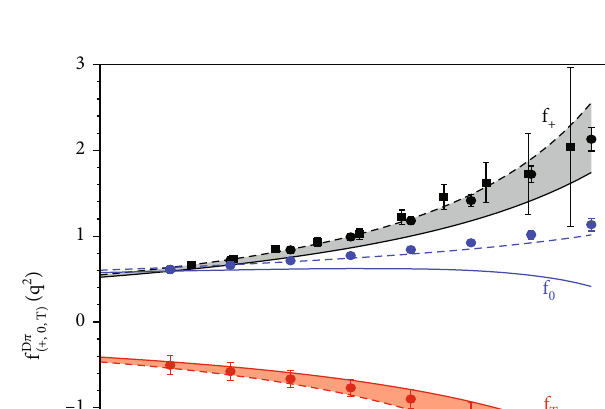
0 Þ = 0 : 737 ð 4 Þ from the BES III DK + ð